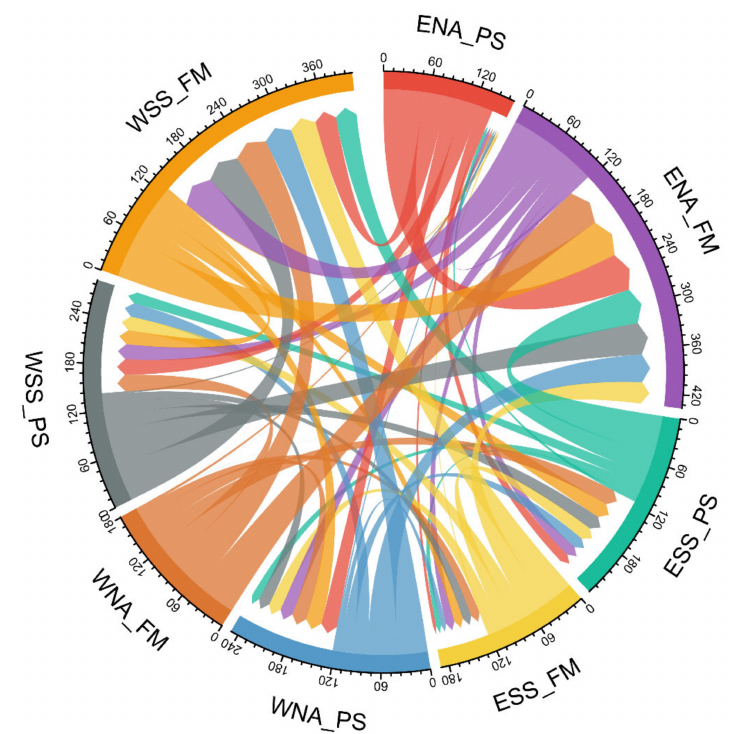
Figure 5. Circular plot of migration/gene flows resulting from the Bayesian coalescent approach in Migrate-n. Numbers around the perimeter illustrate values of 2 Nm = θ × M (the number of immigrants). The arrow signs and their width represent the direction and extent of gene flows between specified groups (ENA_PS: Eastern North African pastoralists; ENA_FM: Eastern North African farmers; WNA_PS: Western North African pastoralists; WNA_FM: Western North African farmers; ESS_PS: Eastern Sahel/Savannah pastoralists; ESS_FM: Eastern Sahel/Savannah farmers; WSS_PS: Western Sahel/Savannah pastoralists; WSS_FM: Western Sahel/Savannah